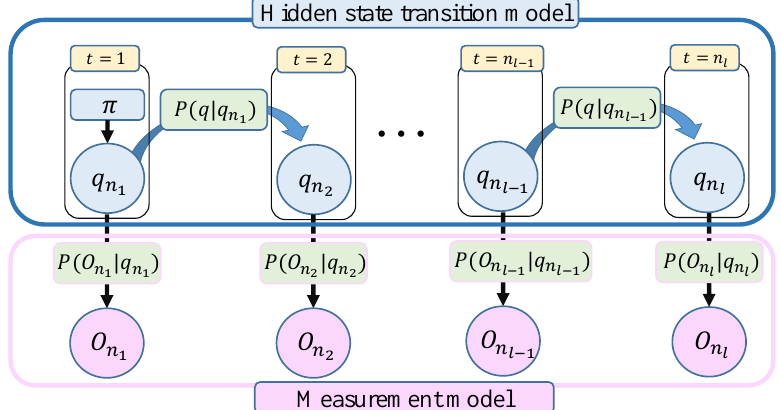
Figure 1. Graphic representation of a discrete hidden Markov model